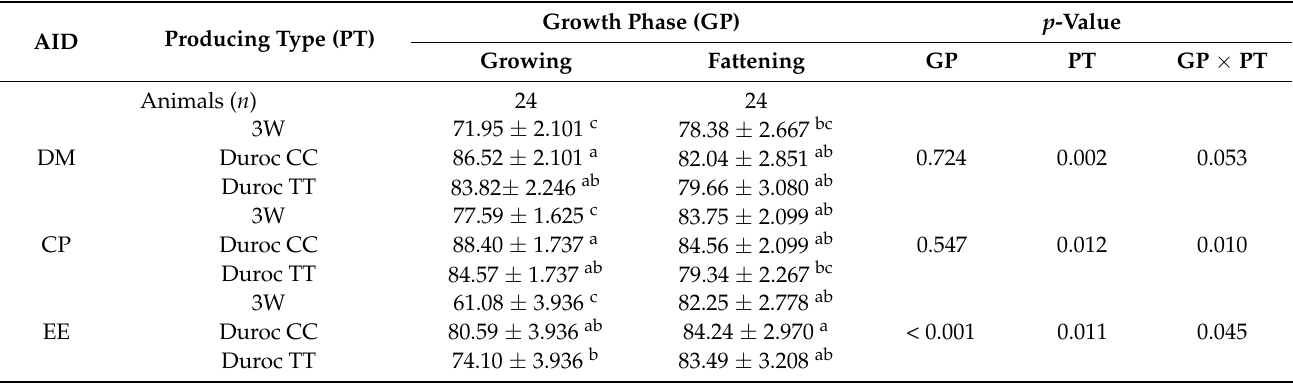
Table 4. Least square means ( ± SE) for apparent ileal digestibility (AID) of dry matter (DM), crude protein (CP), and ether extract (EE), between three-way (3W) crossbred pigs and purebred Duroc pigs of TT/CC SCD genotype, belonging to two growth phases (growing vs. fattening).